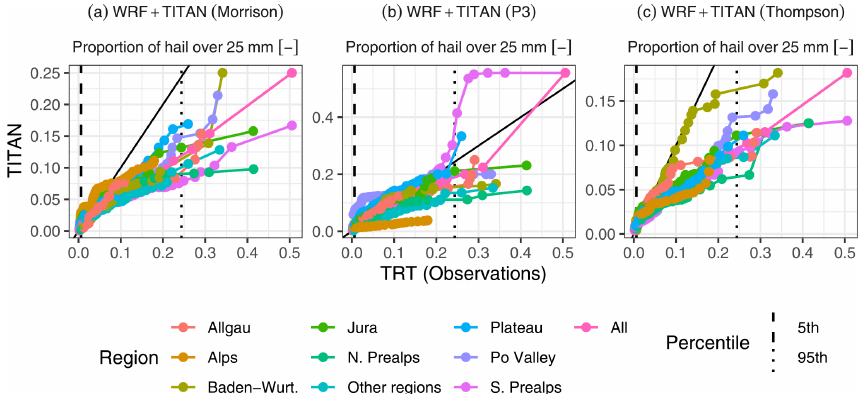
Figure 10. Quantile-to-quantile (QQ) comparisons of the proportion of pixels with maximum hail size over 25mm for cell detections for which this proportion was greater than zero. The black solid line is the 1 : 1 line. The vertical dashed lines show the 95th and 99th percentiles in the TRT distributions.